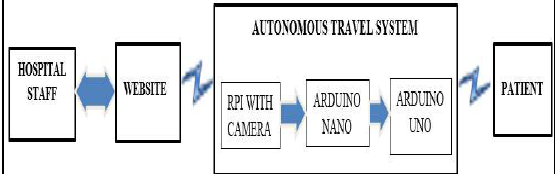
Fig. 5. Block Diagram of the